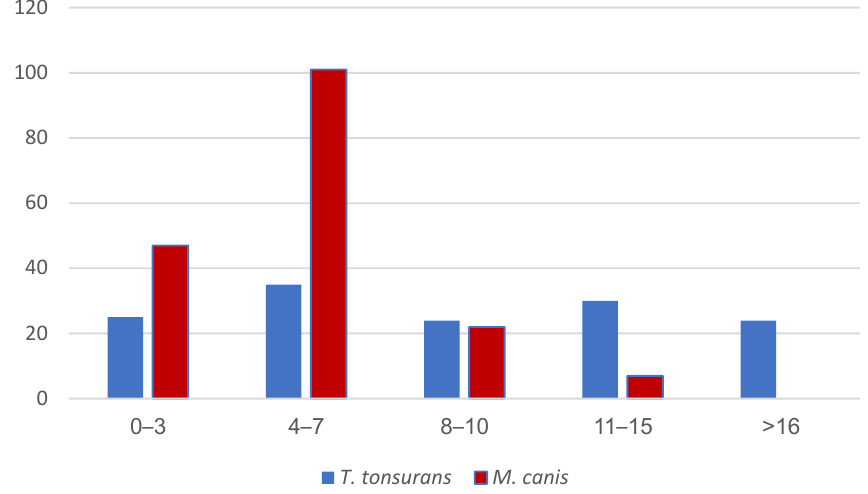
Figure 2. Age distribution of M. canis and T. tonsurans across study population. p < 0.001.